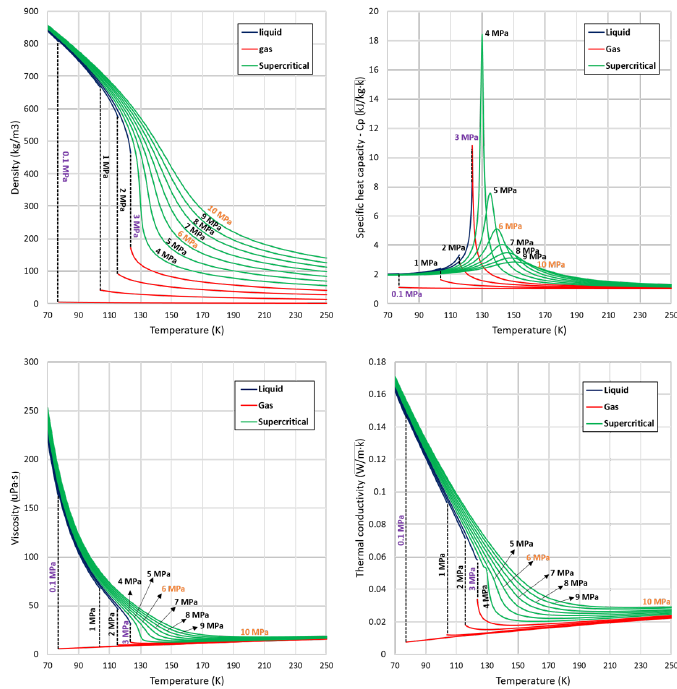
Figure 3. Plots of density ( top-left ), isobaric specific heat capacity ( top-right ), viscosity ( botton-left ) and thermal conductivity ( bottom-right ) at pressures from 0.1 MPa to 10 MPa using NIST [17] data. The subcritical pressures at which the cryogenic jet has been analysed in this paper are shown with a purple label and the supercritical pressures at which the cryogenic jet has been simulated in this paper are shown with an orange